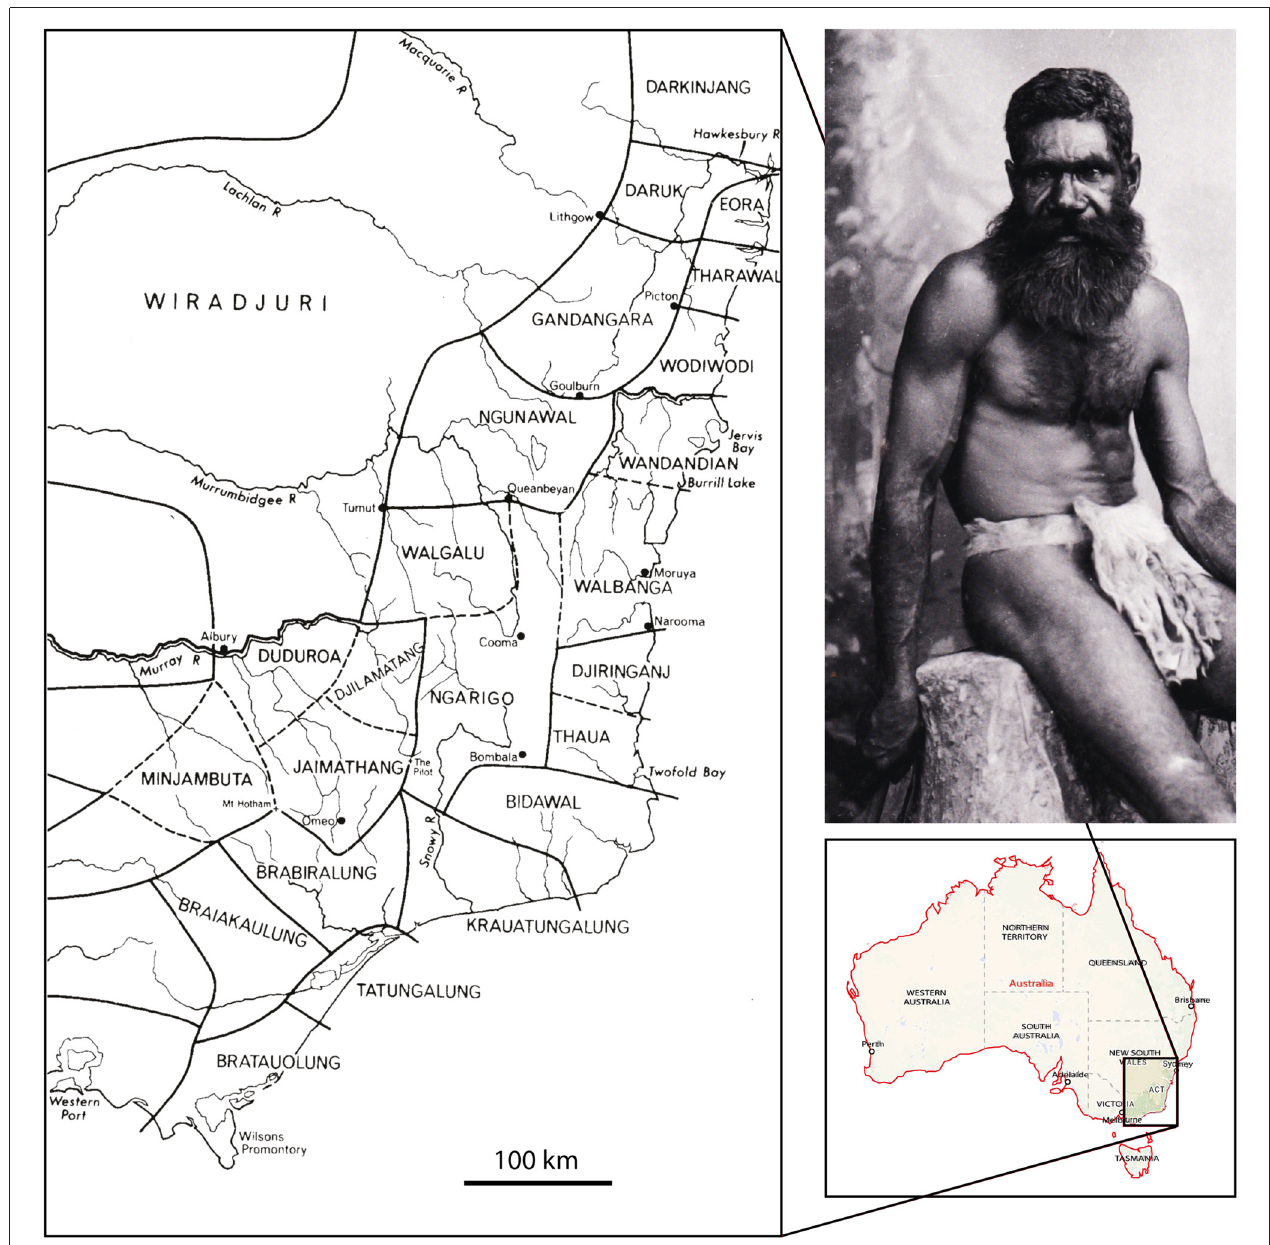
FIGURE 4 | The traditional Aboriginal tribal boundaries of southeastern Australia, and a 19th century portrait of an Aboriginal man from the Monaro district of the Snowy Mountains wearing the apron-like bridda bridda. The map is a reproduction of Tindale’s 1974 map of indigenous group boundaries existing at the time of first European settlement in Australia (Tindale, 1974). It is not intended to represent contemporary relationships to land. © Tony Tindale and Beryl George, 1974. Portrait: Photo no. 1304 by Henry King (1855–1923), from the Tyrrell Collection (7903 glass plate negatives from the studios of Henry King and Charles Kerry (1858–1928), held at the Powerhouse Museum, Sydney, and available through the Commons on